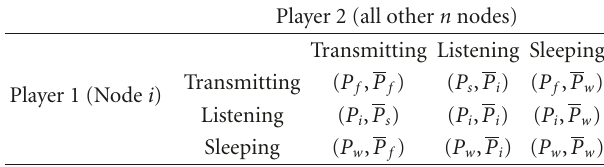
Table 2: Strategy